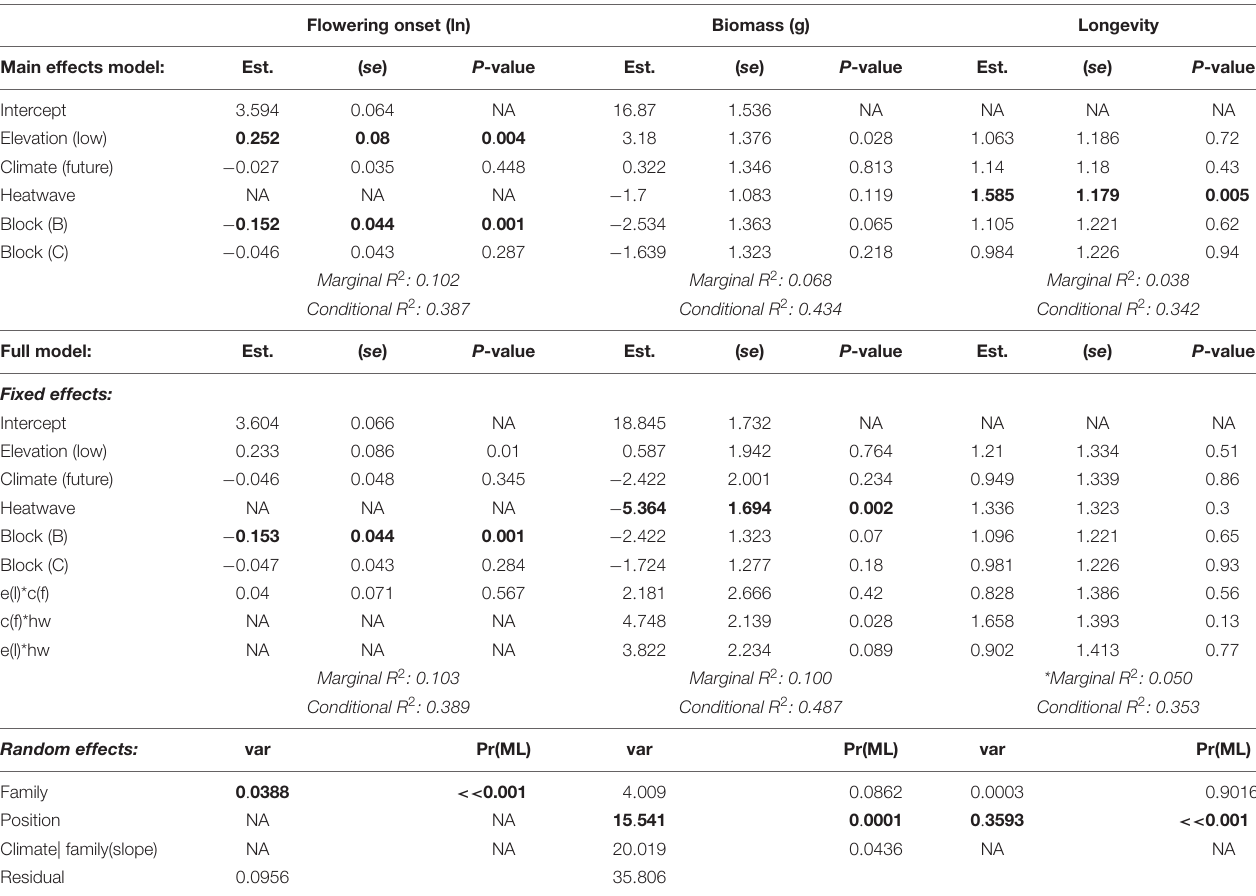
TABLE 2 | Effects of temperature treatments on phenology, biomass and longevity: results from linear random intercept models (flowering onset), from linear random slope models (biomass) and from Cox proportional hazards model (longevity). Flowering onset (ln) Biomass (g)